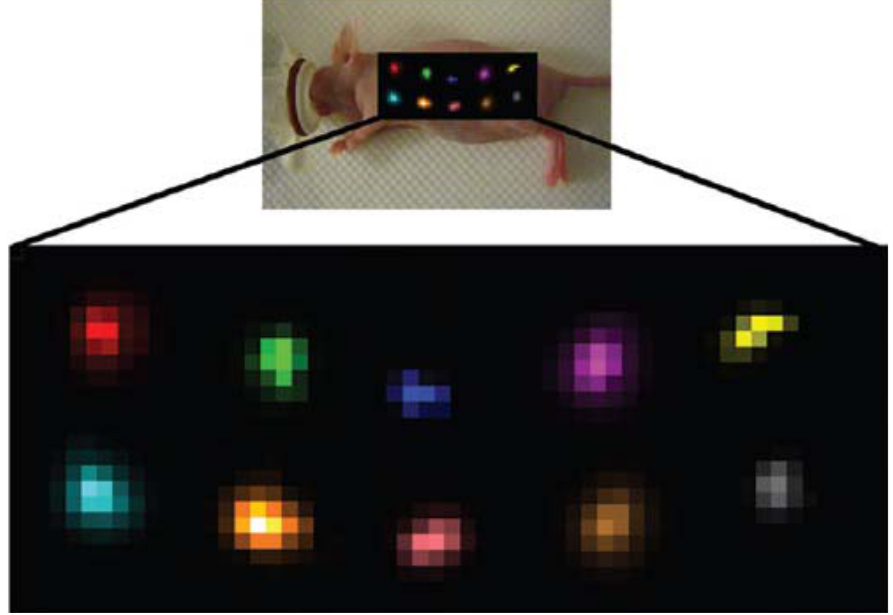
Figure 9. Evaluation of multiplexing 10 different SERS nanoparticles in vivo . Raman map of 10 different SERS particles injected subcutaneously. in a nude mouse. Arbitrary colors have been assigned to each unique SERS nanoparticle batch injected. Panels below depict separate channels associated with each of the injected SERS nanoparticles. Grayscale bar to the right depicts the Raman intensity, where white represents the maximum intensity and black represents no intensity. The postprocessing software was able to successfully separate all 10 SERS nanoparticles into their respective channels with minimal crosstalk. © The National Academy of